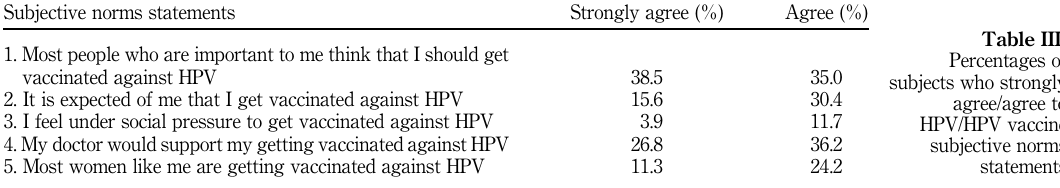
Table III. Percentages